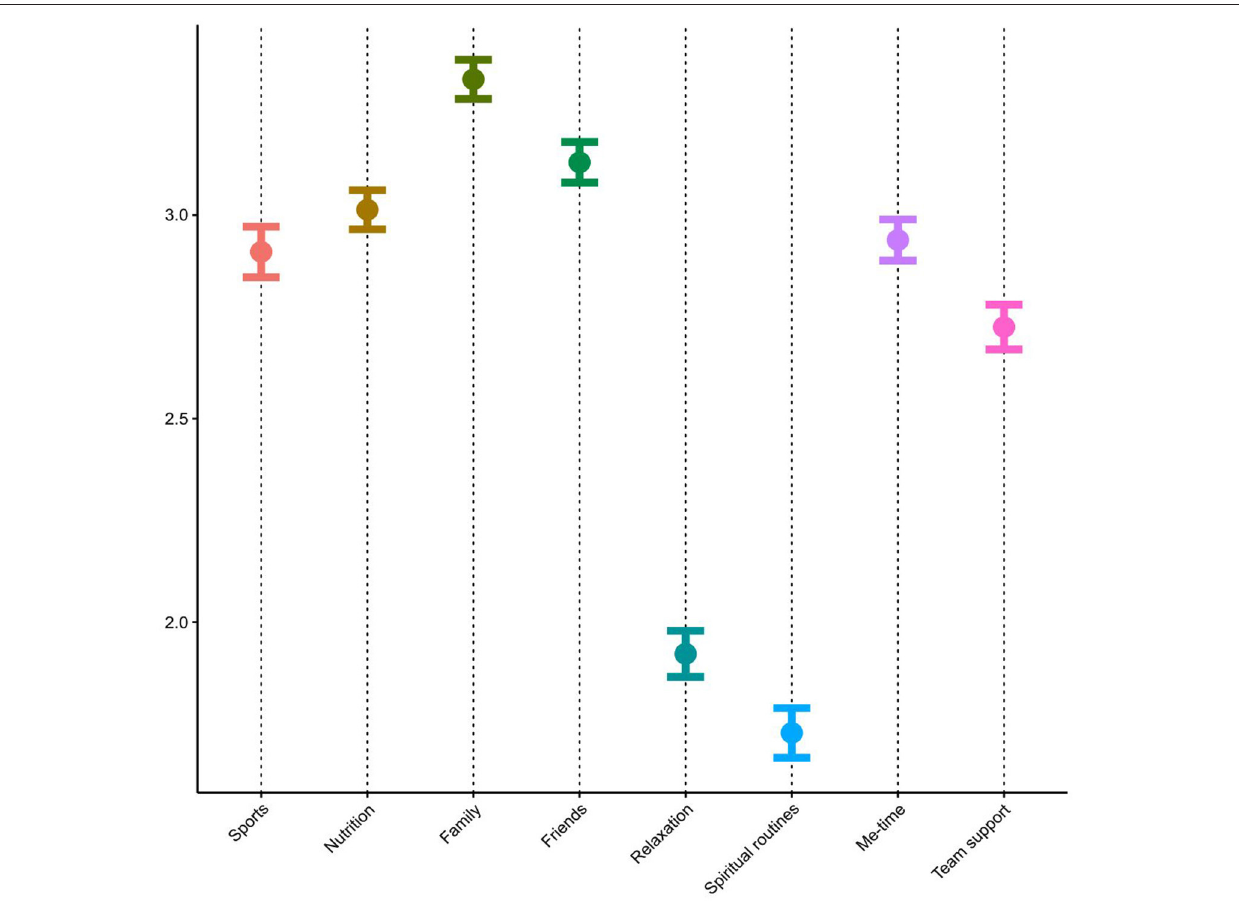
linear trends, we applied two-sided non-parametric Jonckheere- Terpstra tests for ordinal data with 1,000 permutations of the p -value. We chose to report effect sizes whenever